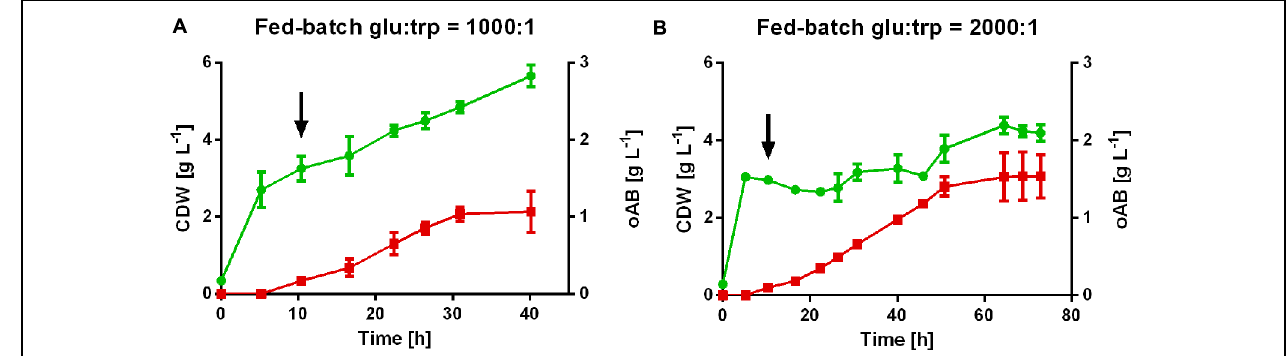
FIGURE 4 | Tryptophan-limited fed-batch cultures of P. putida KT2440 (cid:2) trpDC pSEVA234_ aroG D146N _trpE S40F G in controlled bioreactors with different feeding approaches. (A) Feed molar ratio of glucose to tryptophan 1,000:1. (B) Feed molar ratio of glucose-to-tryptophan 2,000:1. (cid:2) , oAB concentration. The arrows indicate the start of the feed after the initial batch